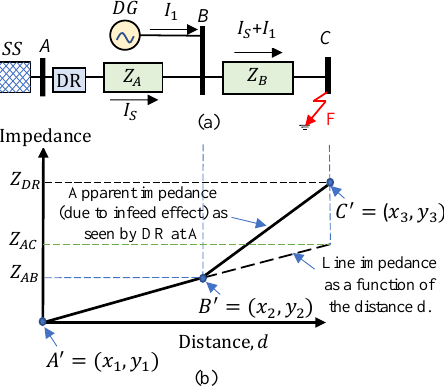
Figure 5. Infeed effect on distance protection: ( a ) radial distribution feeder with one DG; ( b ) impedance seen by DR at A .